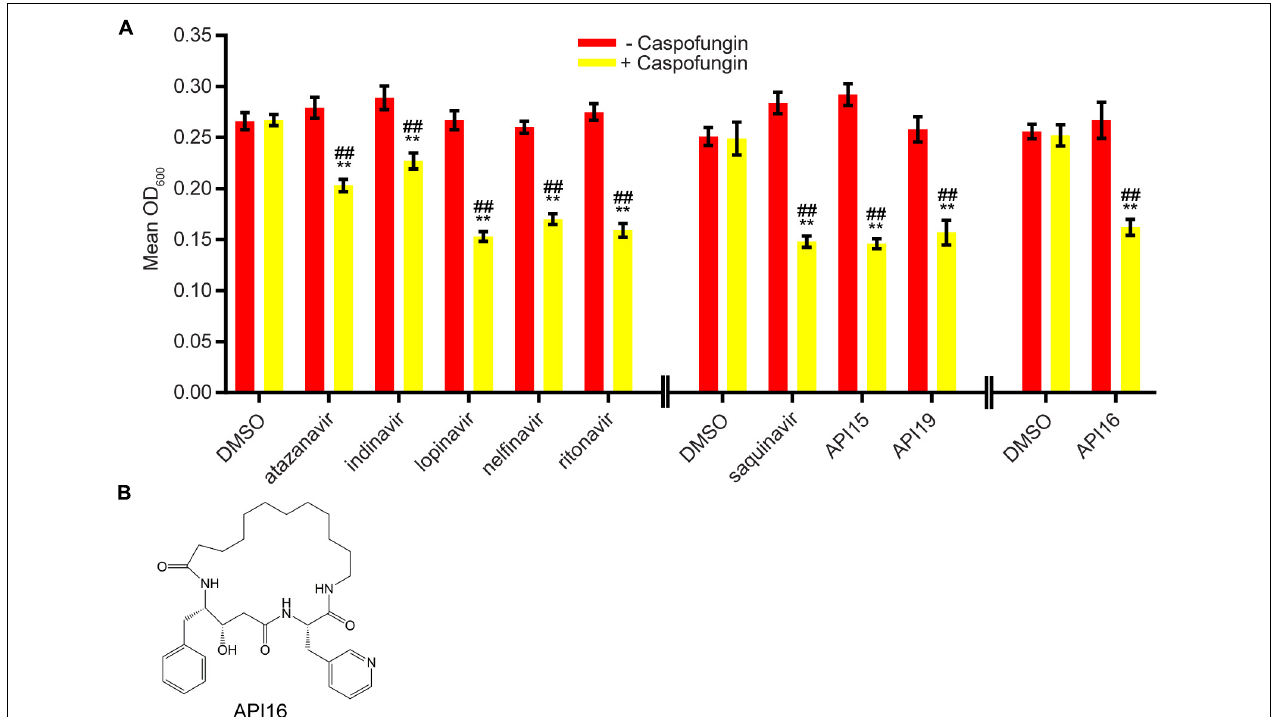
FIGURE 4 | Nine aspartyl protease inhibitors disrupted mature biofilms in combination with the antifungal agent caspofungin. (A) Statistically significant hits from the combination Disruption Biofilm Assays with caspofungin. For each compound, the wells with caspofungin (+caspofungin) are indicated in yellow and the wells without caspofungin (–caspofungin) are indicated in red. Mean OD 600 readings with standard deviations are shown; significant differences from the compound without the caspofungin control (e.g., atazanavir, – caspofungin), as determined by Welch’s t -test (two-tailed, assuming unequal variance) with the Bonferroni Correction, are indicated for α = 0.05 (*) and α = 0.01 (**). Significant differences from the caspofungin without compound control (e.g., DMSO, +caspofungin), as determined by Welch’s t -test (two-tailed, assuming unequal variance) with the Bonferroni Correction, are indicated for α = 0.05 (#) and α = 0.01 (##). Data from separate plates are separated by two vertical lines on the x -axis; the DMSO solvent control is shown for each plate. (B) Structure of the aspartyl protease inhibitor